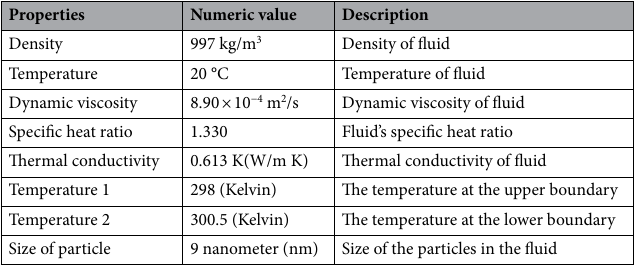
Table 1. The following parameters have been utilized in calculations.